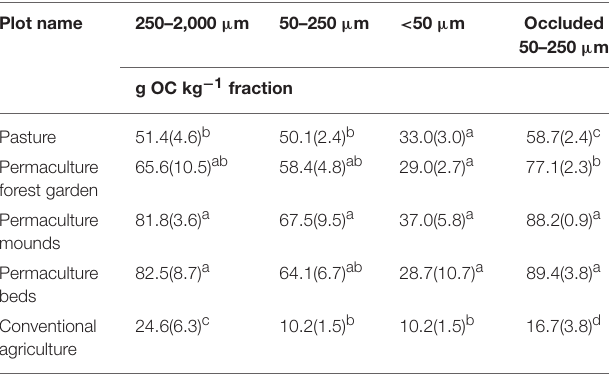
TABLE 7 | OC concentrations in the soil aggregate-size fractions (in grams OC per kilo